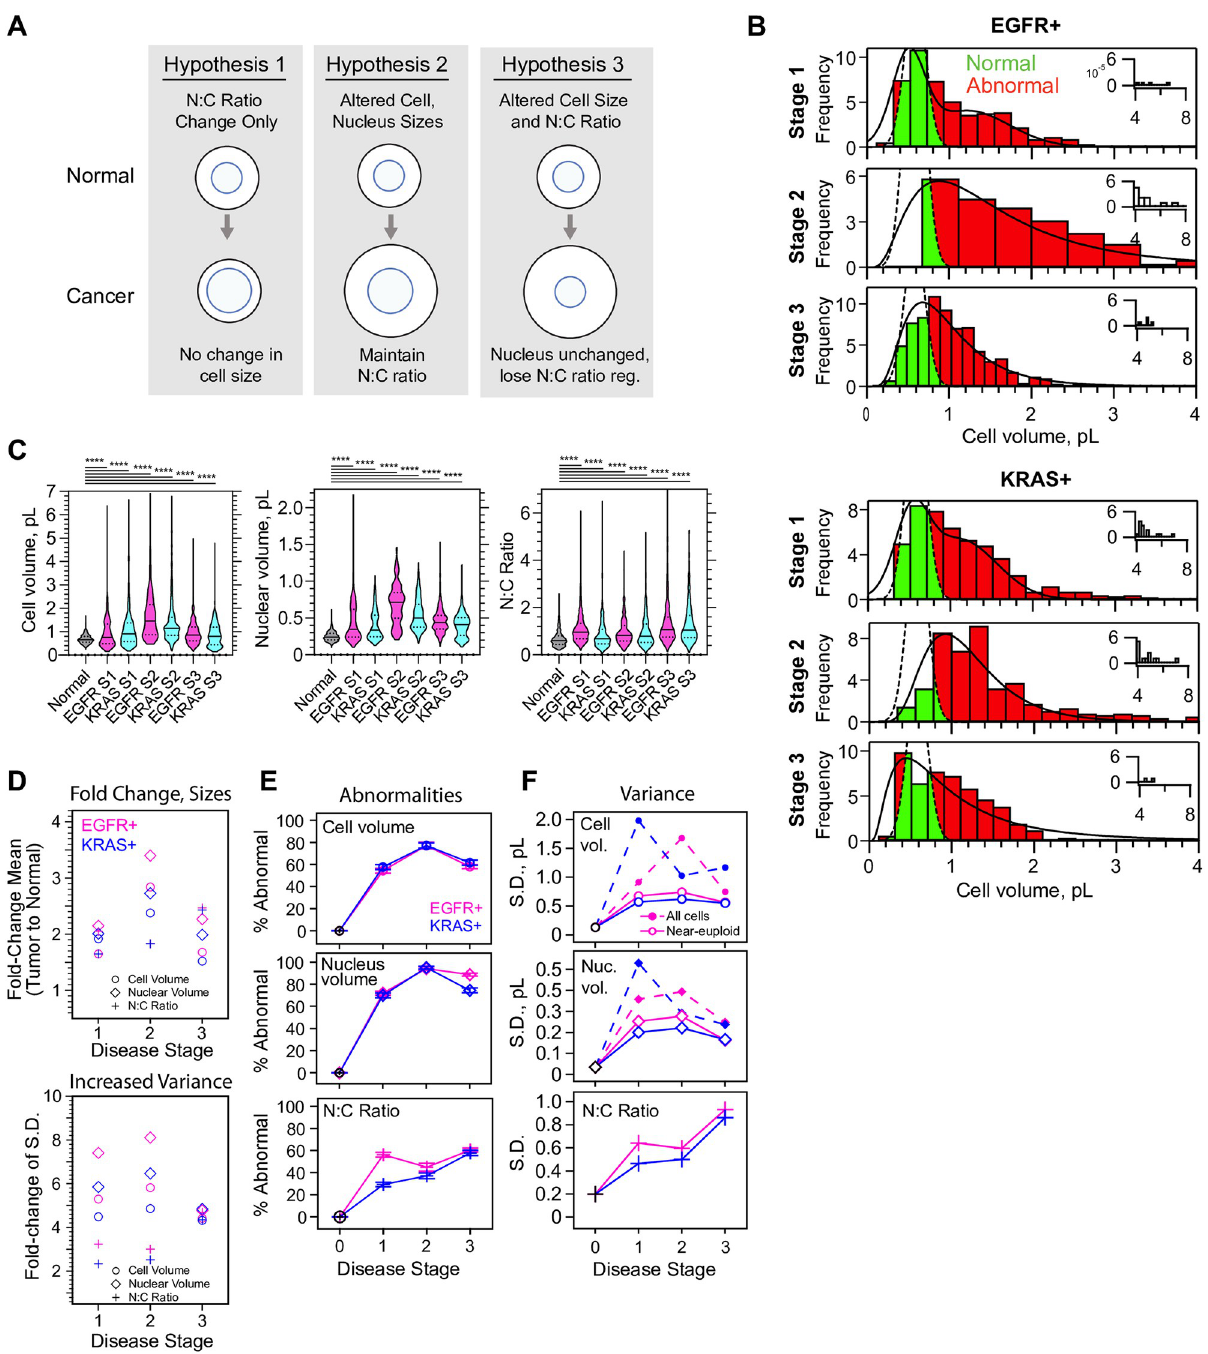
Fig 2. Quantitation of cell and nucleus dimensions in EGFR+ and KRAS+ lung tumors. A., Schematic: potential outcomes for cell and nucleus scaling in cancerous cells, hypothesis 2 is that LA retains nuclear scaling function. B., histograms of cell volumes of near-euploid (1.6–4.4n) cells (N = 21, n = 2683) as a function of EGFR+ (N = 10, n = 1411) or KRAS+ (N = 11, n = 1260) genotype and stage. Green, cell volumes for tumor cells within the boundaries of the 2n normal AT2 cells; Red, cell volumes outside the Gaussian distribution of 2n population of Normal AT2 cell volumes. C., violin plots for near-euploid cells show very significantly abnormal scaling and significant changes in distributions between stages. 1–2 and 2–3. Colors alternating for visibility, normal in grey. Kruskal-Wallis ANOVA, p < 1 x 10 − 4 ( ���� ). Select pairwise p-values for Mann-Whitney tests in Tables 1–3. D.- E., quantitation of differences between near-euploid tumor cells and 2n wild-type AT2 cells. Circles, cell volume. Diamonds, nuclear volume. Crosses, N:C ratio. D., Corresponding fold change (tumor-to-normal) for cell sizes (top); standard deviation (bottom). Error bars � 2.7 x 10 − 3 omitted for clarity Magenta, EGFR+, Blue, KRAS+. E., percentages of cells which fall within the regression fits to histograms for tumor cells, but outside the Gaussian fit to